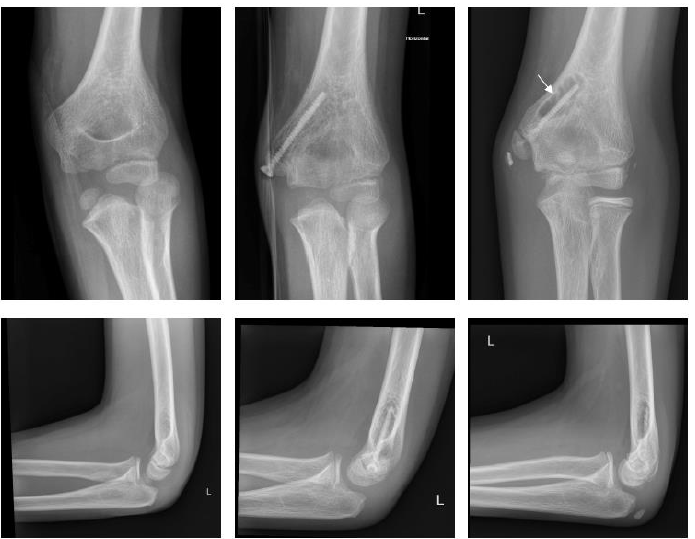
Figure 3. Fracture of medial epicondyle with Magnezix ® screw: preop, 1 month postop, 12 months postop (left to right). Arrow marking gas formation.